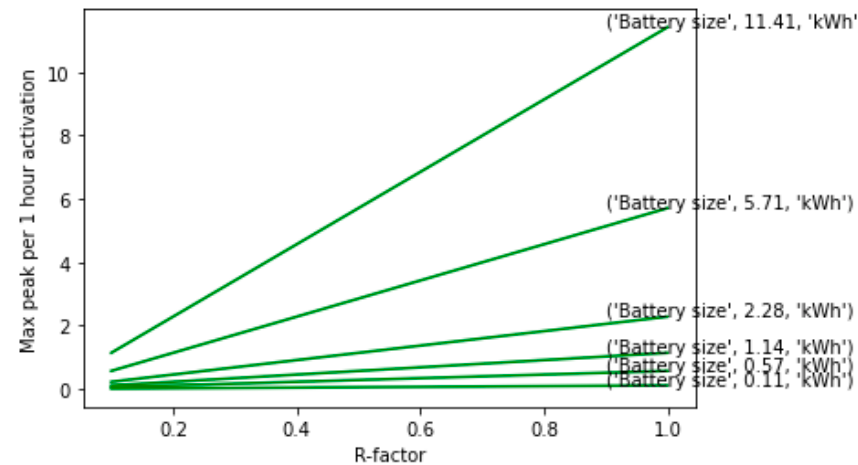
Figure 8. Relation between an increasing R, the battery size and the activated flexibility.